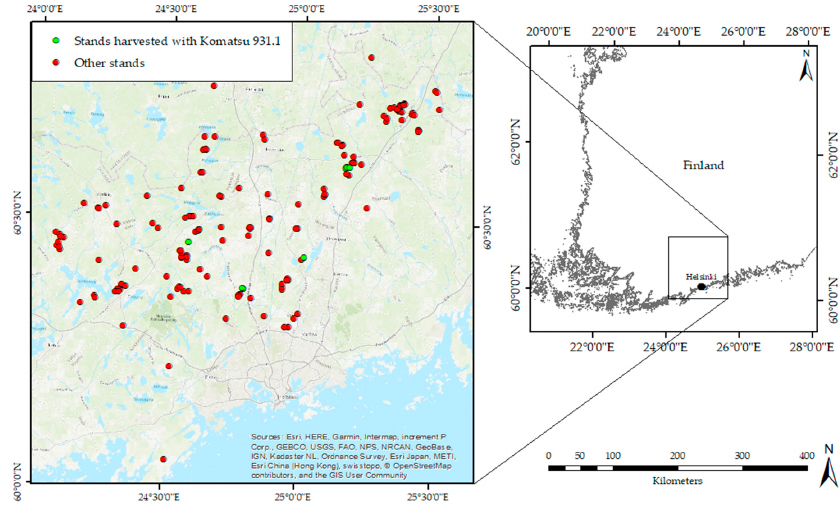
Figure 1. The study area, in the Uusimaa region of Southern Finland (60.50°N, 24.70°E). Stem- and harvester-production files (STM and HPR files) were collected from the information systems of six harvesters operating in the study area between August 2015 and September 2016. Four of the harvesters were made by Ponsse (Vieremä, Finland), one by Komatsu Forest (Umeå, Sweden), and one by John Deere (Moline, Illinois, United States). The harvester data included 158 clear-cut stands (>0.5 ha), including 207,073 stems. Global navigation satellite system (GNSS)-derived positions of the harvester were available for each stem in the harvester data. Additionally, specific position parameters for the harvester head were available from harvester data recorded by the Komatsu Forest 931.1 harvester. Note that the scale applies to figure on the